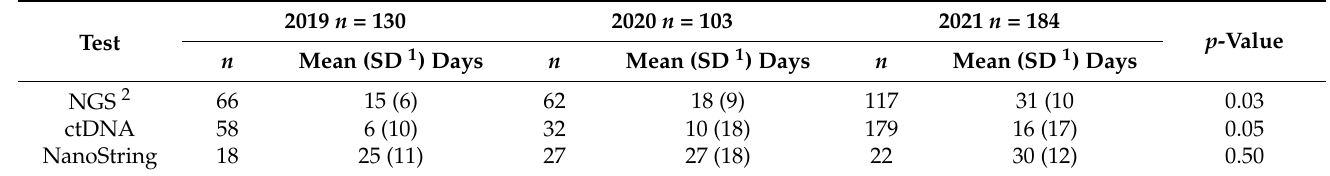
Table 8. Mean wait time for molecular